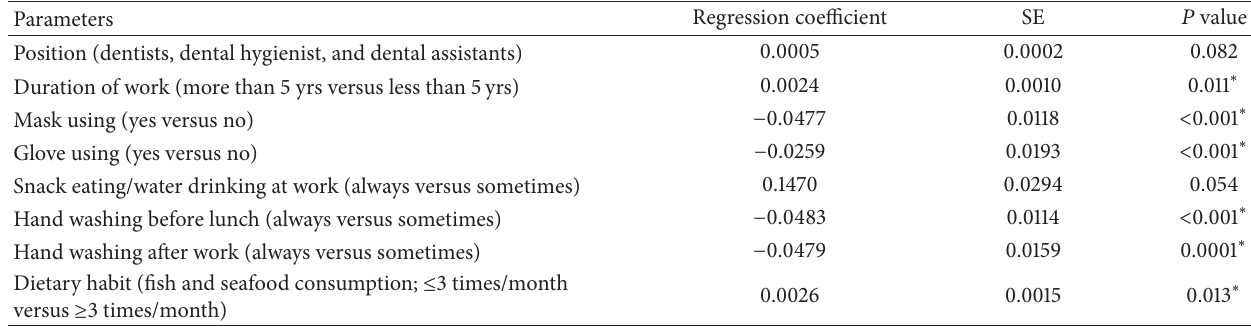
Table 5: Multiple linear regression of dietary habit, occupational life style, PPEs used, and personal hygiene behaviors on urinary mercury levels in dental health